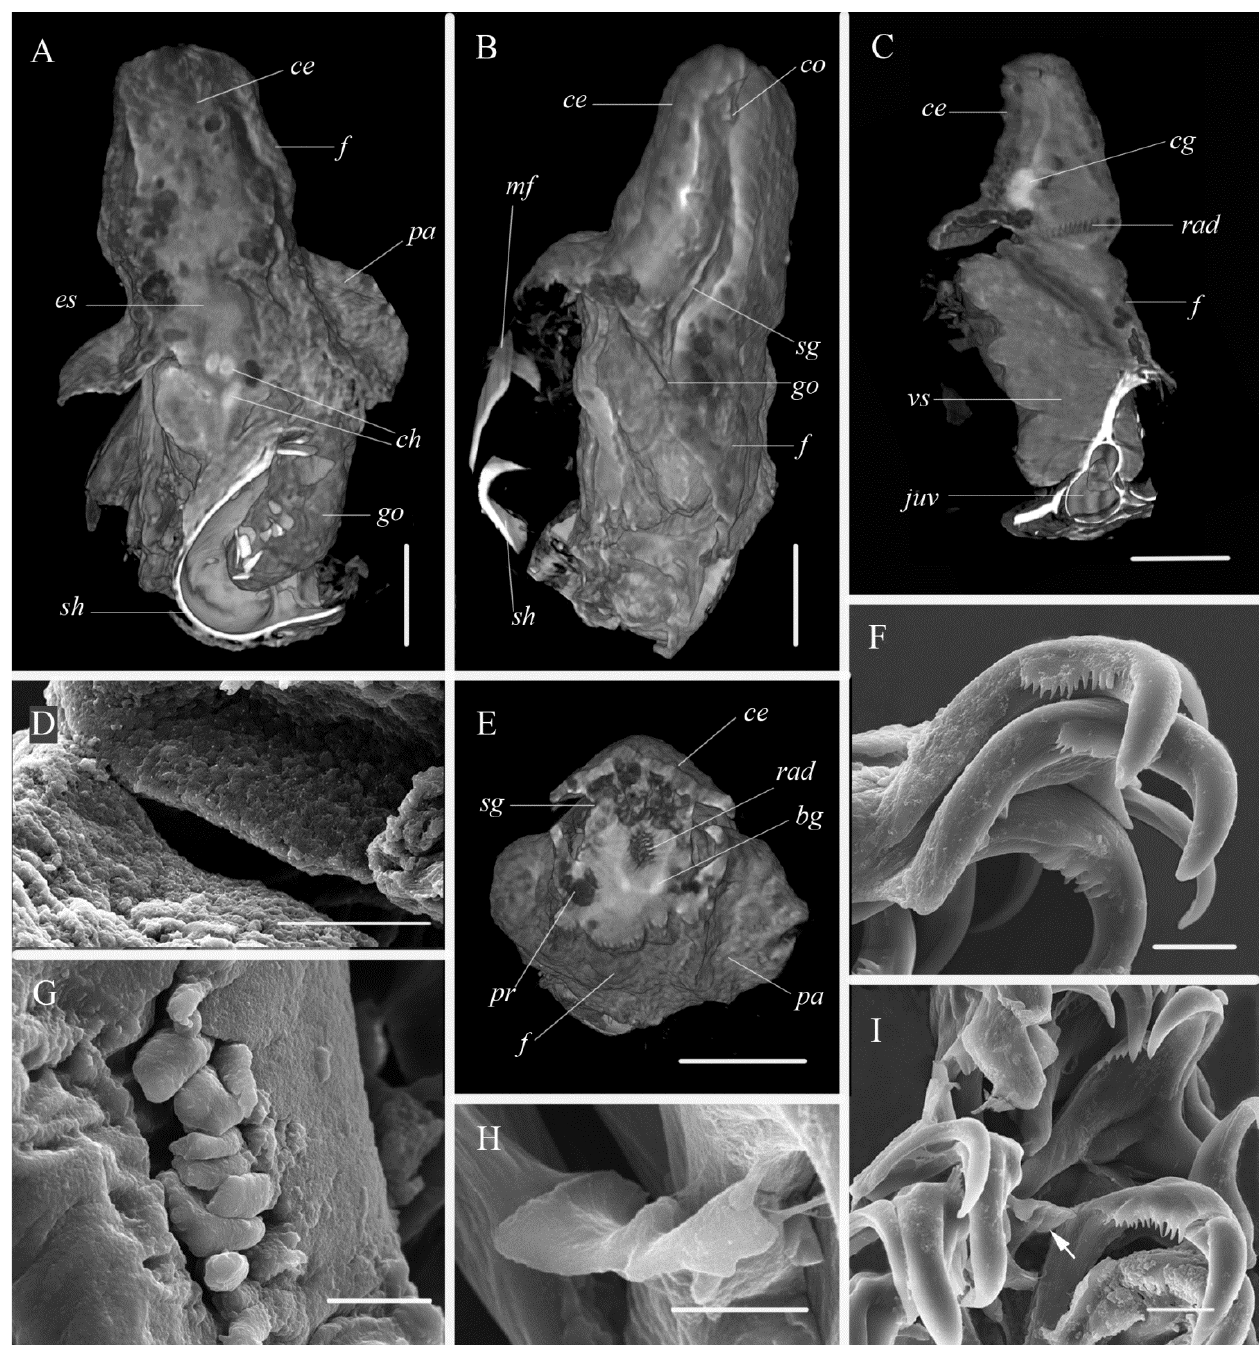
Figure 4. Philinissima denticulata specimen from the White Sea (( A – C , E ), mCT) and specimen from the Barents Sea (( D , F – J ), SEM), internal morphology. ( A )—specimen, dorsal view; ( B )—specimen, lateral view; ( C )—specimen, optical section through radula region, lateral view; ( D )—chitin ridges of gizzard; ( E )—specimen, optical section through radula region, frontal view; ( F )—radula, lateral teeth of right side; ( G )—jaws; ( H )—radula, rachidian tooth enlarged; ( I )—radula, rachidian teeth marked by arrow. Abbreviations: bg—buccal ganglia, ce—cephalic shield; cg—cerebro-pedal ganglia, ch—chitinous zones of gizzard, co—copulatory system opening; es—esophagus, f—foot;